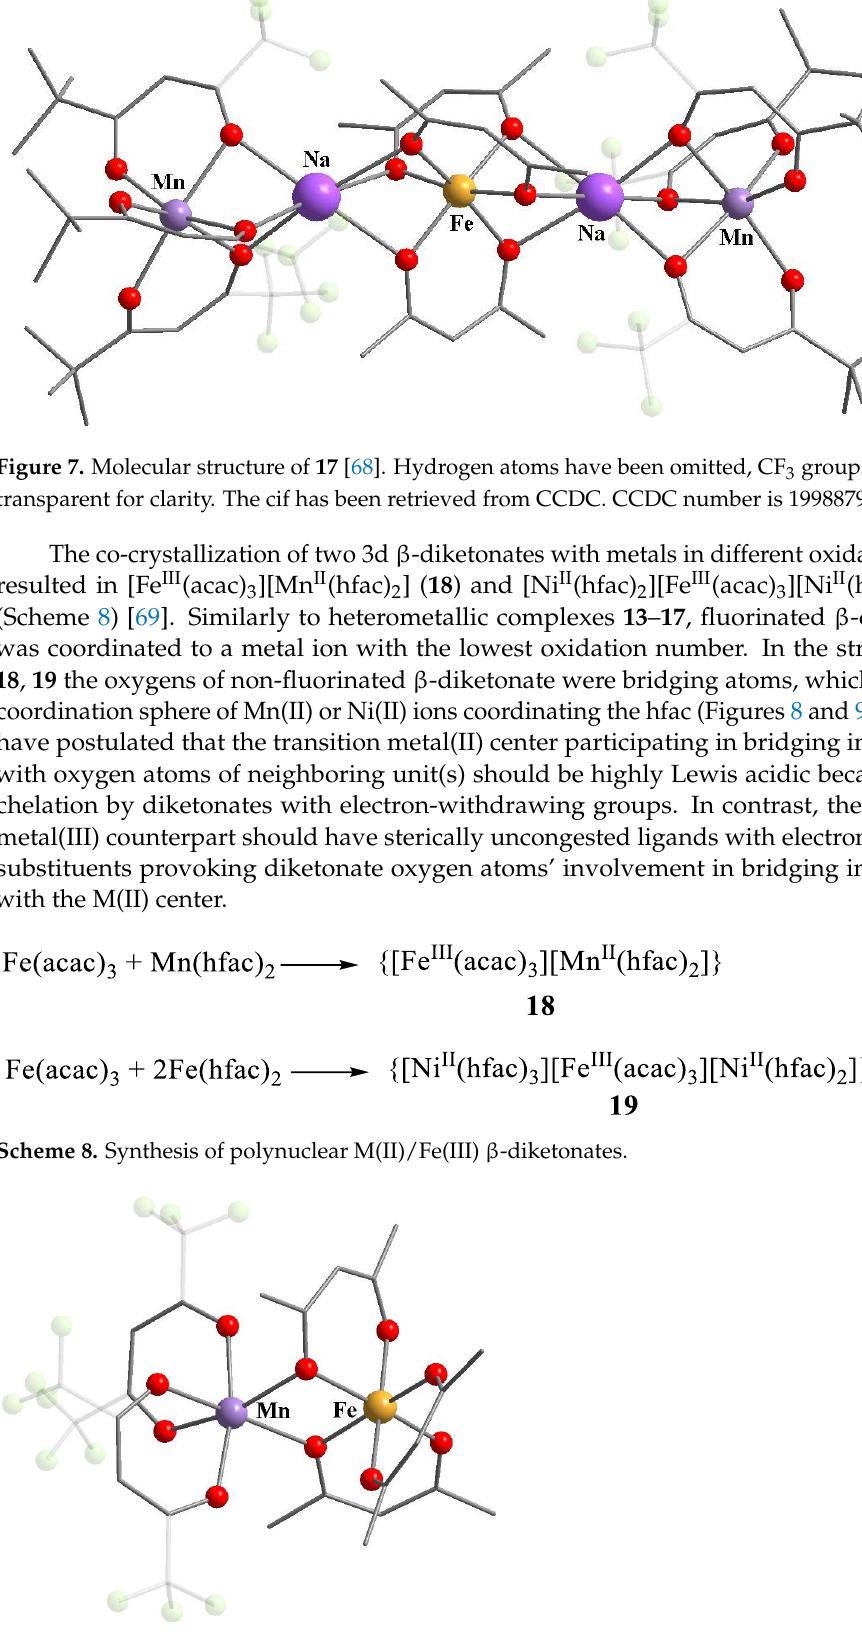
Figure 8. Molecular structure of 18 [69]. Hydrogen atoms have been omitted, CF 3 groups of hfac are transparent for clarity. The cif has been retrieved from CCDC. CCDC number is 1040552.